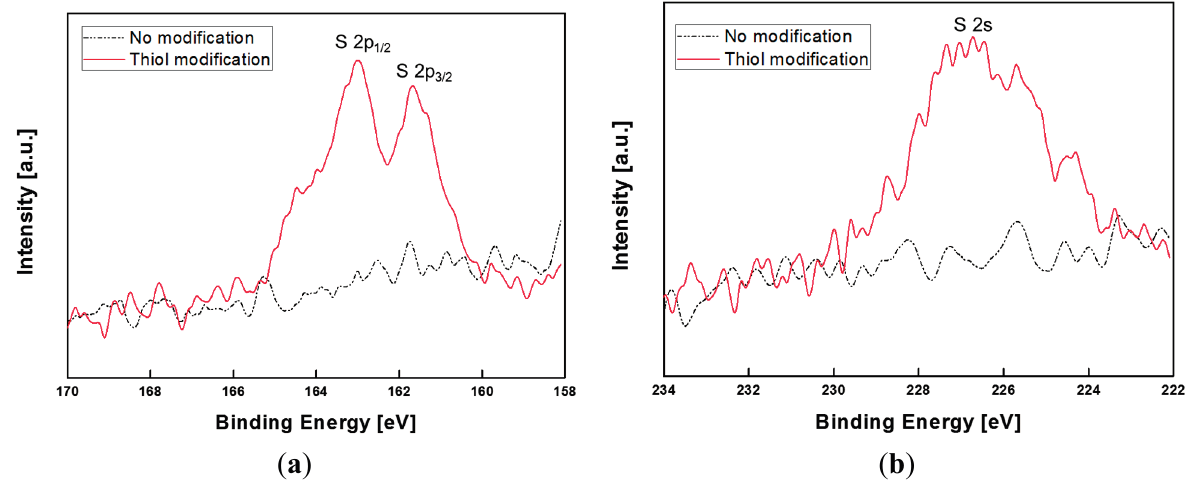
Figure 5. ( a ) S 2p; ( b ) S 2s high-resolution XPS spectra after SAM immobilization of the Au-deposited GaN